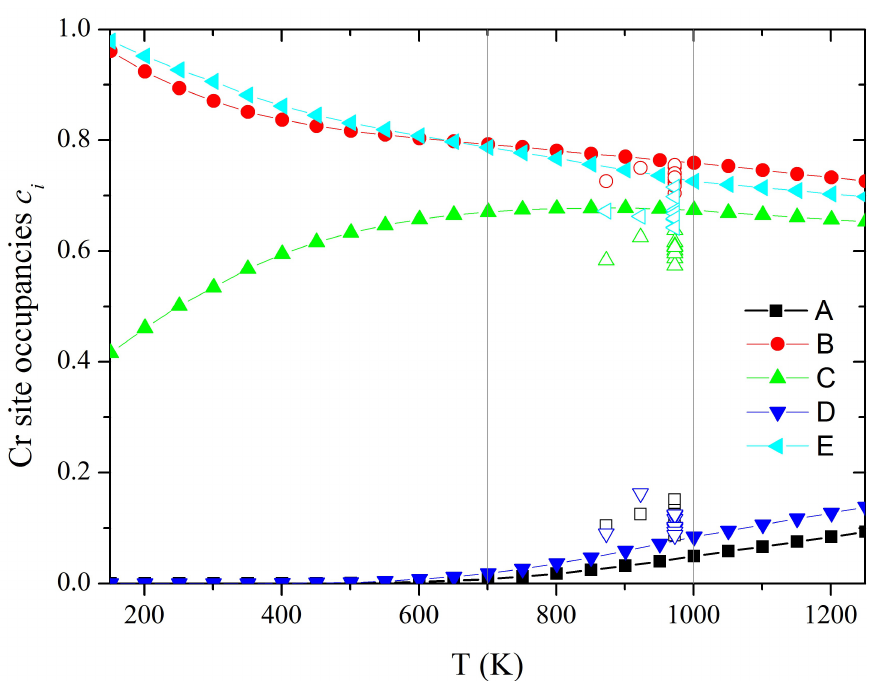
σ -phase. The empty symbols Cr 0 . 5 0 . 5